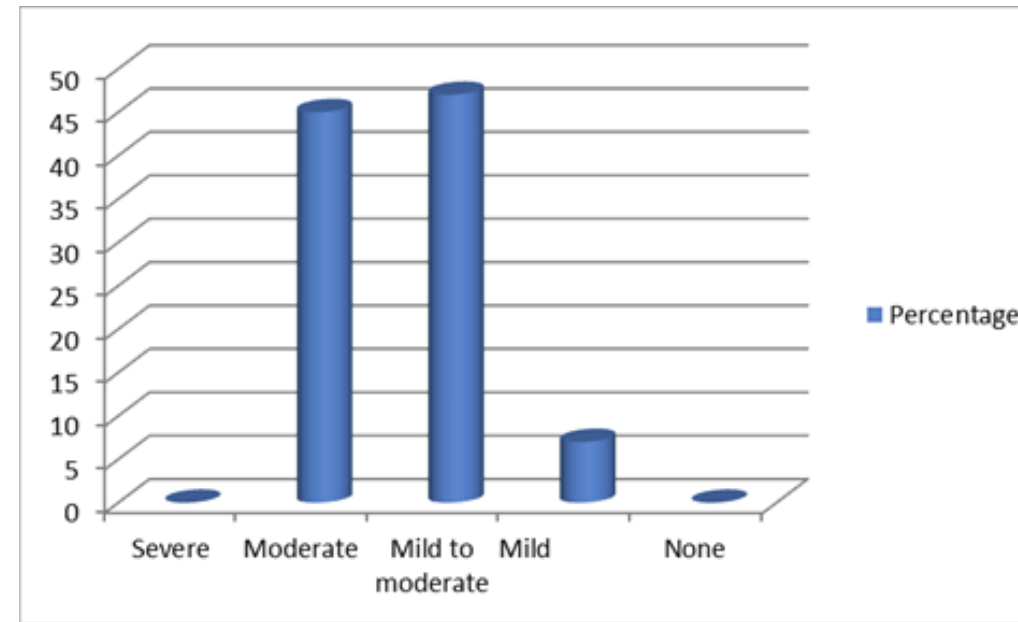
Figure 7: The prevalence of intercourse